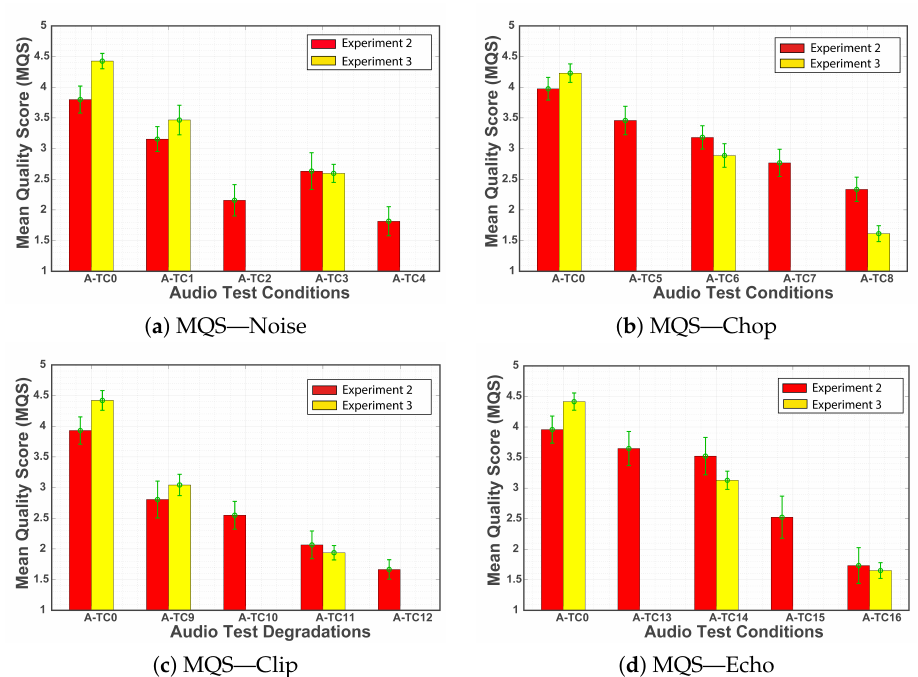
Figure 13. Average MQS values for different audio test conditions in Experiments 2 and 3.